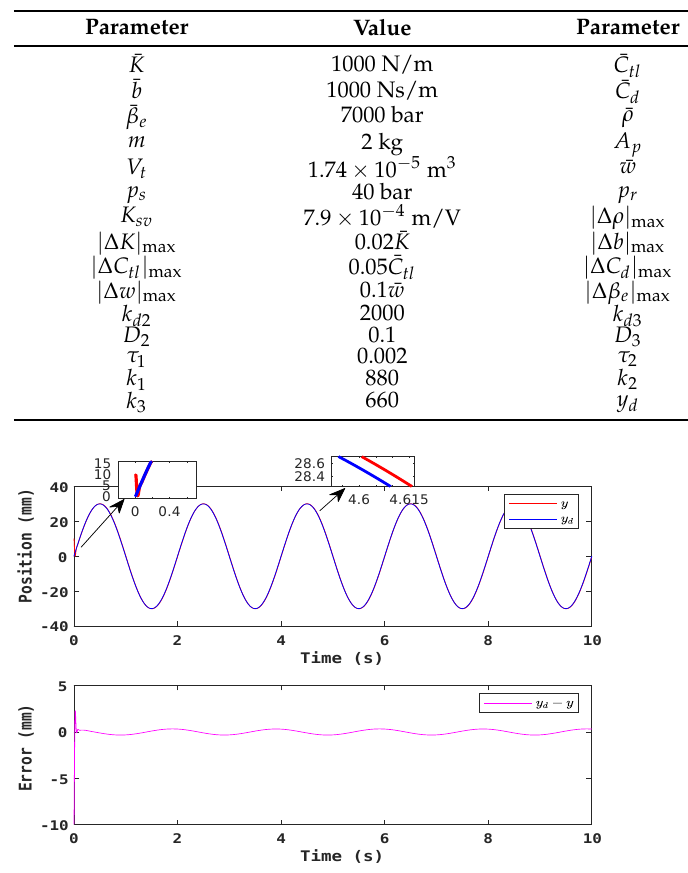
Table 1. The simulation parameters of EHS.